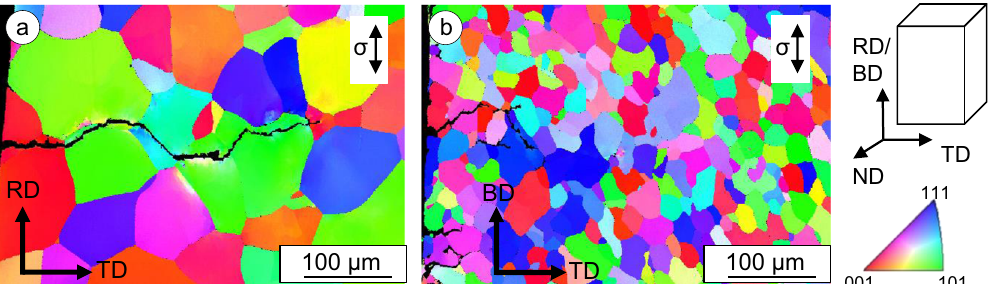
Fig. 7 EBSD orientation mappings of fatigued specimens with indication in normal direction (ND). a HR iron (250 MPa, 2.3 × 10 5 cycles) b EBM iron (250 MPa, 1 × 10 5 cycles); see main text for details; the rolling direction (RD), the building direction (BD) and transverse direction (TD) are marked in the fi gures.